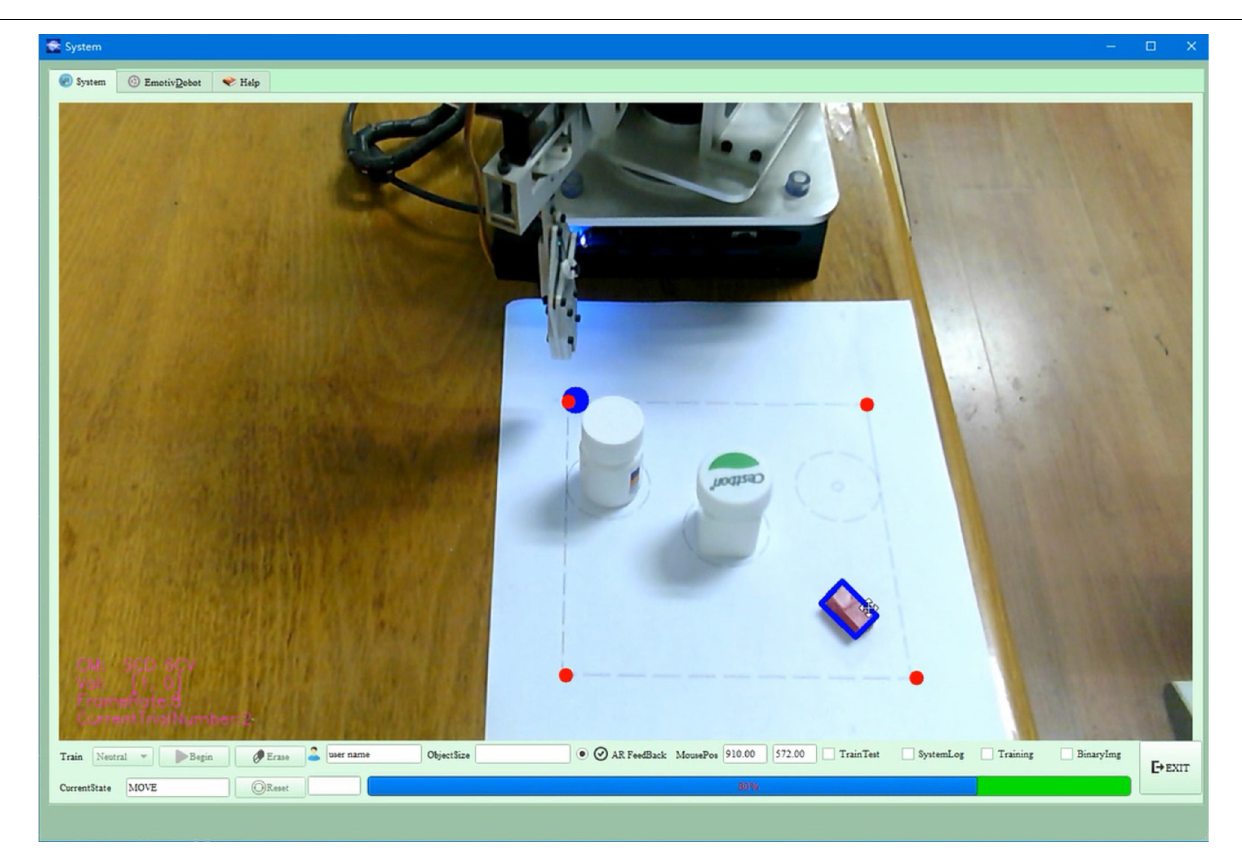
FIGURE 4 | The selected target highlighted with a virtual rectangle frame surrounding